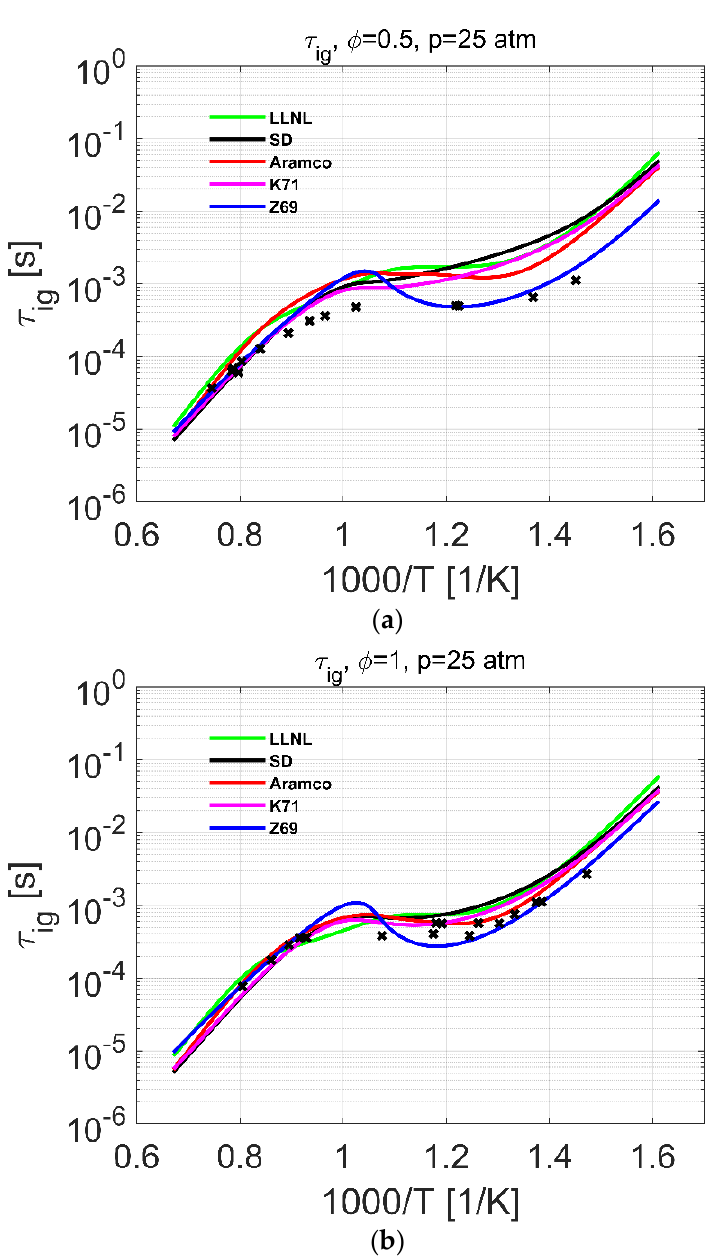
Figure 5. Ignition delay time for DME-air mixtures at 25 atm and ϕ = 0.5 in ( a ) and ϕ = 1.0 in ( b ). Legend: experimental data for τ ig from (×) Burke et al. [17]. Mechanism predictions from Z69 in blue, LLNL in green [28], Aramco in red [17], K71 in magenta [32] and San Diego in black [30].